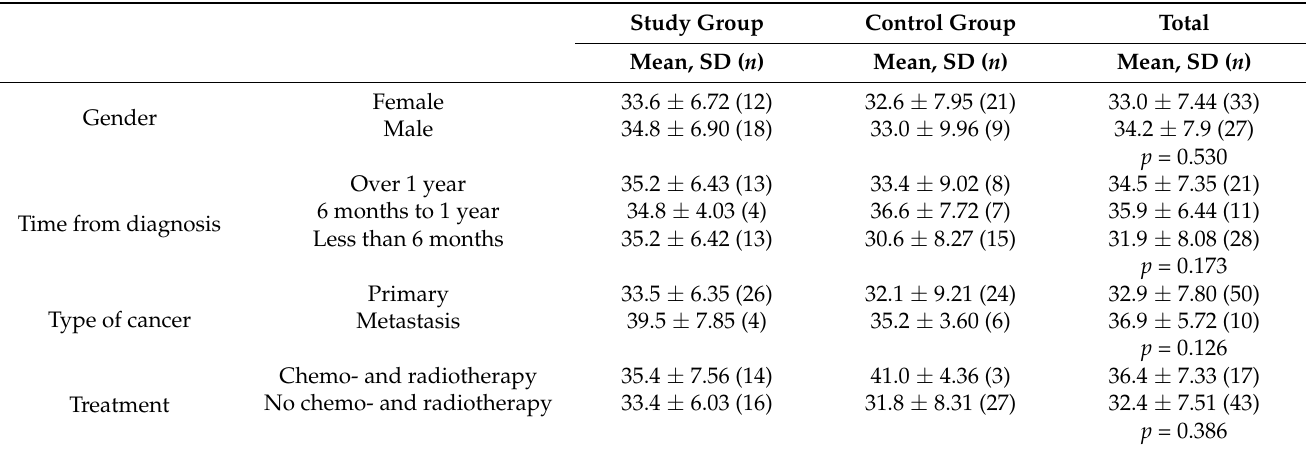
Table 3. Overall quality of life (QoL) scores in patients with brain tumors with and without